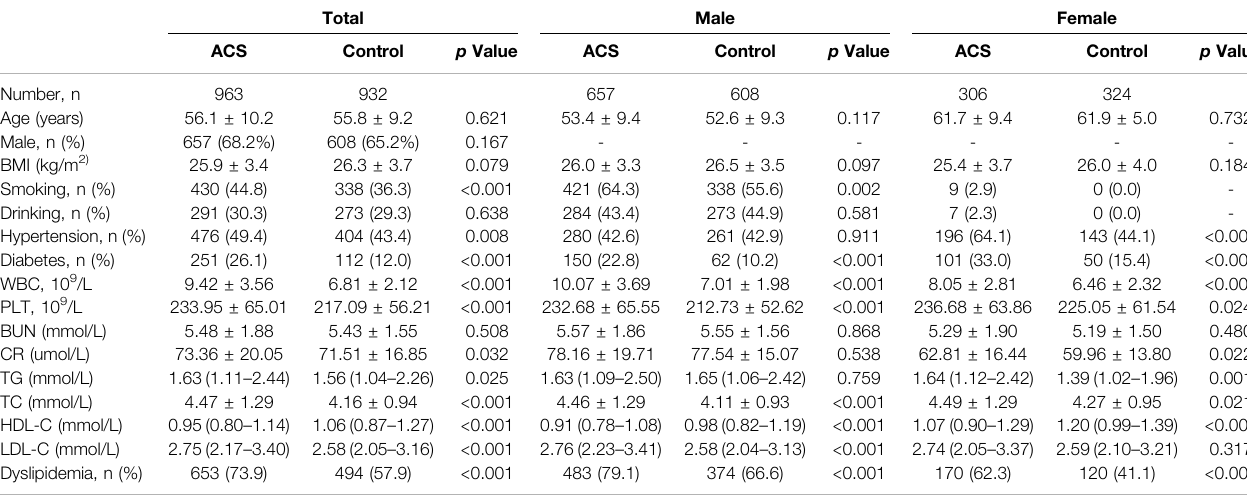
TABLE 1 | Demographic and clinical characteristics of the study